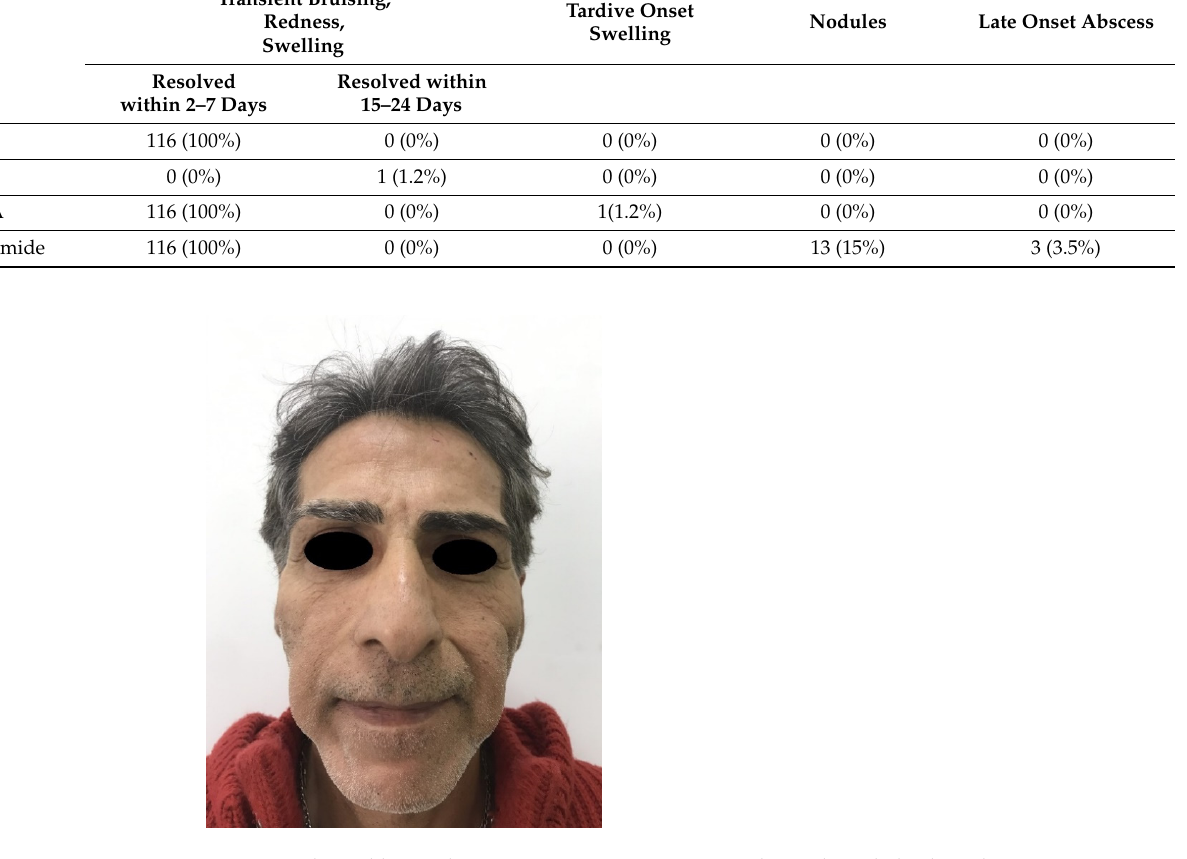
Table 2. Incidence and percentage of complications related to cosmetic medical treatment performed on HIV+ patients presenting facial wasting or head and neck lipodystrophy. Figure 7. A huge degree of swelling, redness and bruising after DCA injections.